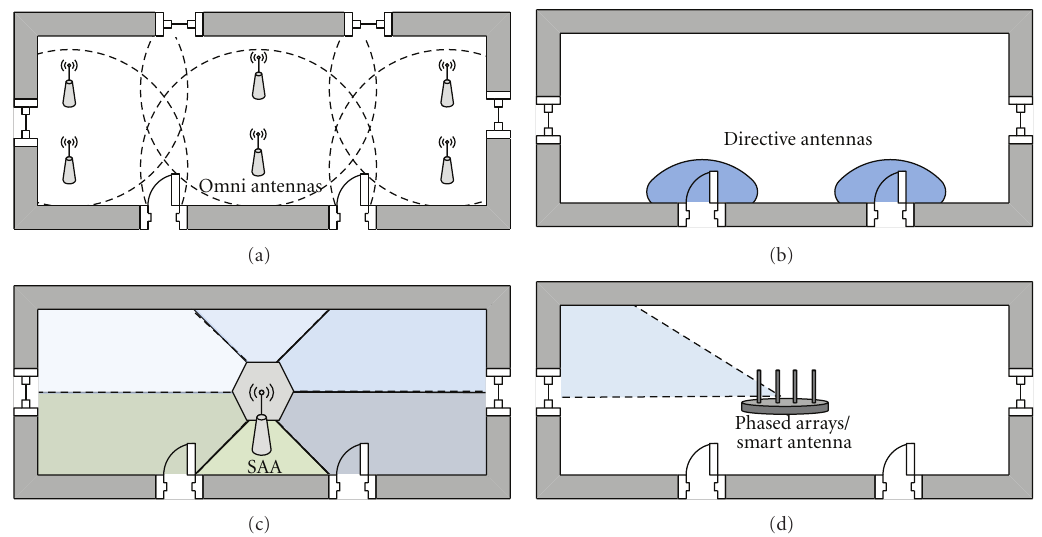
Figure 1: Localization systems models: (a) based on omnidirectional antennas; (b) based on singular pattern directive antenna; (c) integrated with SAA; (d) integrated with phased or smart Antennas.